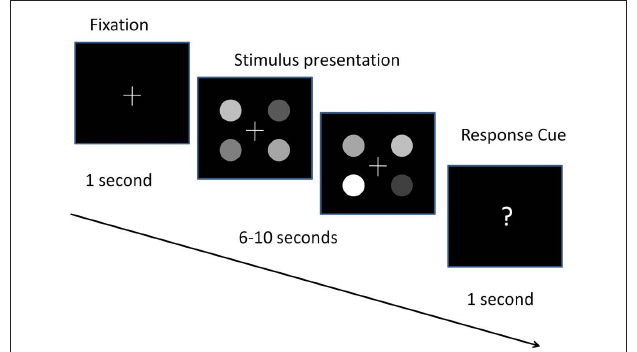
Figure 7 | The time course of an experimental trial.